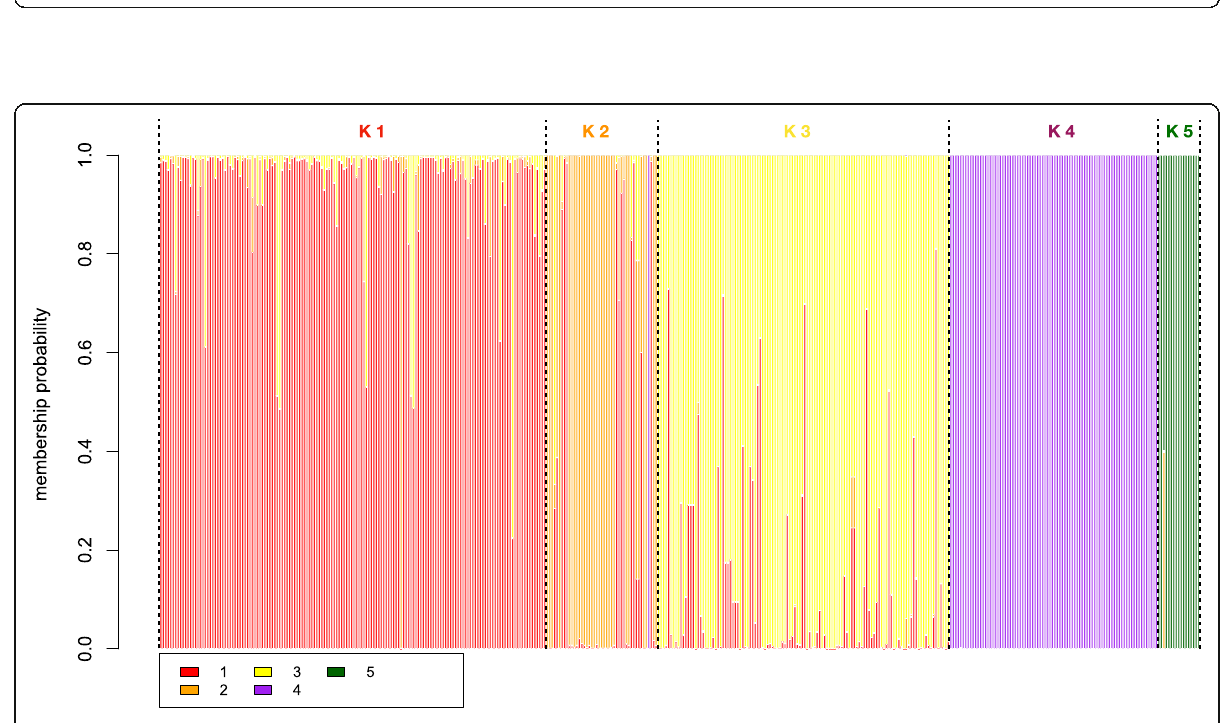
Fig. 2 Discriminant analysis of principal component (DAPC) scatterplot. Showing the relative location of each individual sample in two dimensional space, overlaid by a minimum spanning tree calculated from the squared distance between individual to represent the phylogenetic relationship between inferred clusters. K5, hemp or “ ruderalis ” appears ancestral and the most differentiated group, followed by K4, terpinolene dominant resin accessions. The genetic distance between groups ( Fst ) is indicated on the respective branches of the minimum spanning tree